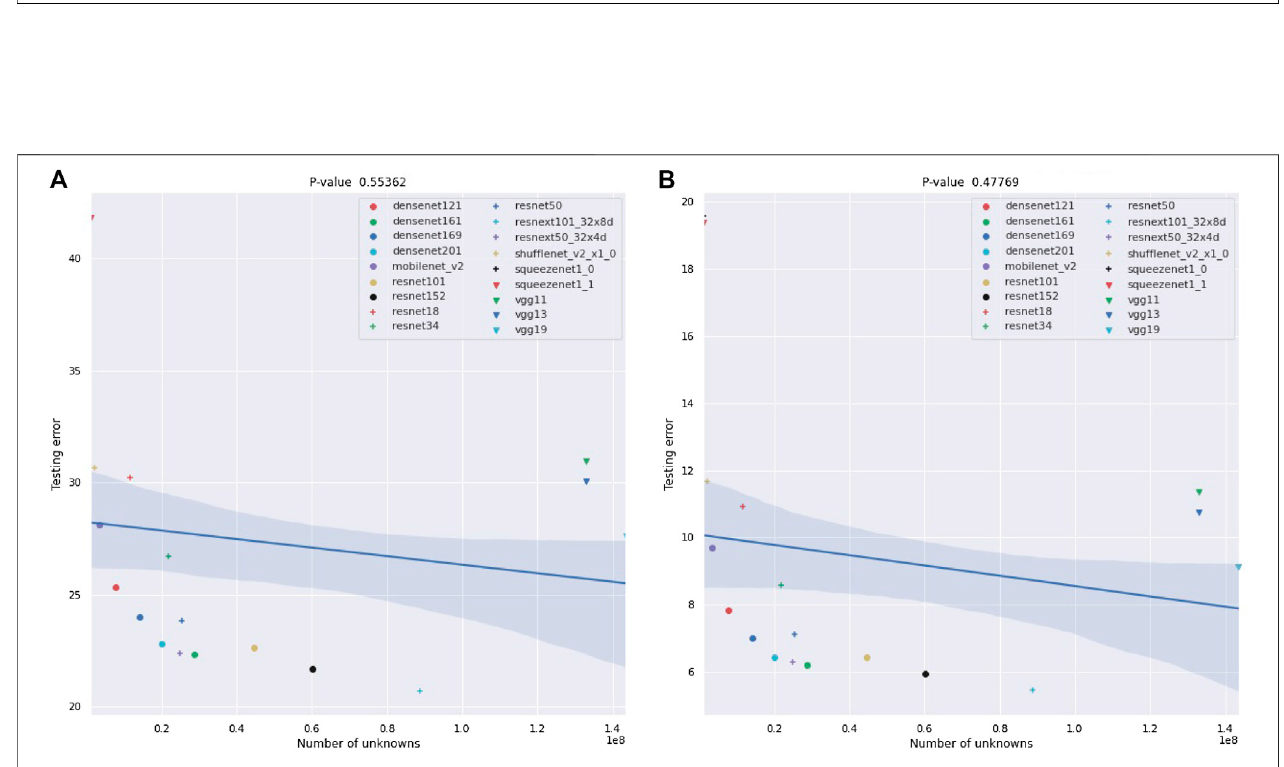
FIGURE 12 | Plots of the best-5 testing error of NNs against their ESD. As in Figure 9 , the testing errors are as provided by [30] and are error rates for testing on ImageNetcropimages. WealsoprovidetherangeoftheESDover10differentexperimentsusinganimagefromtheImageNetdatasetforeach x ,and,again,theranges are quite small relative to the differences between the various networks, though somewhat larger than in the x ∈ {− 1 , 1 } 3 × 224 × 224 . Also in this case, the ESD shows a strong negative correlation with the best-5 error. It is again interesting to note that the ranges of the ESD for each NN are larger in this case then in 9 and 10. We conjecturethatthisisbecauseofthelargerdiversityoftheImageNetdataset.However,the p -valuesarestillquitesmall,eveninthiscase.Thecon fi denceboundsonthe linear fi t are one- σ bounds based on 1,000 bootstrap samples.